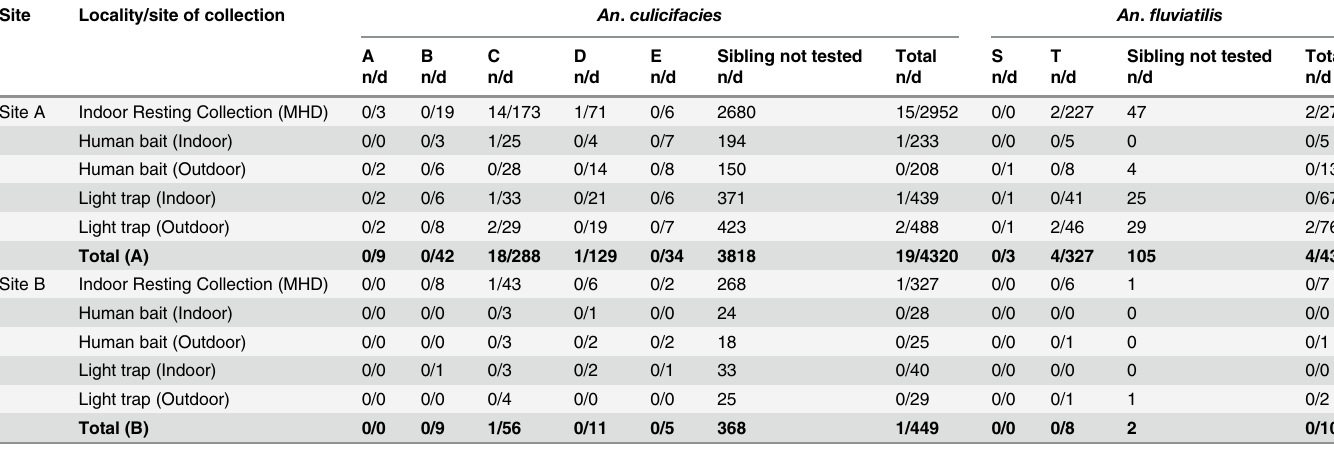
all sampling techniques except that species A was not found in HLCI (Table 3). Sibling species Table 3. Distribution of sibling species and sporozoite positive of An . culicifacies , An . fluviatilis by various sampling techniques in Bargi and Sihora PHCs, Jabalpur, Madhya Pradesh. Site Locality/site of